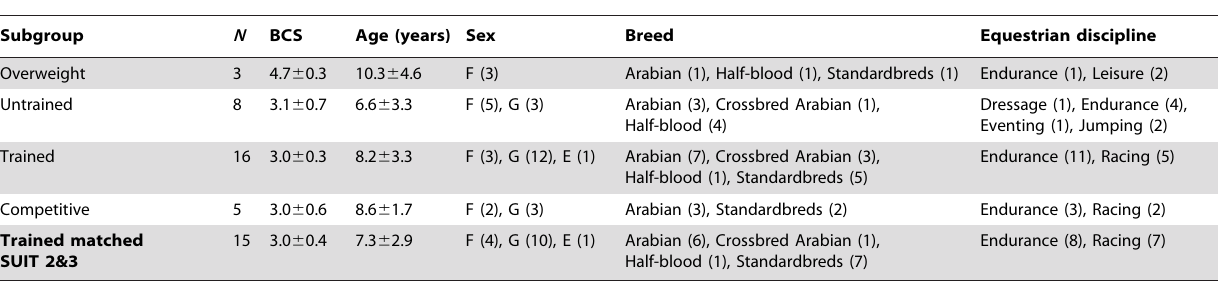
Table 1. Characteristics of horses used in the study.